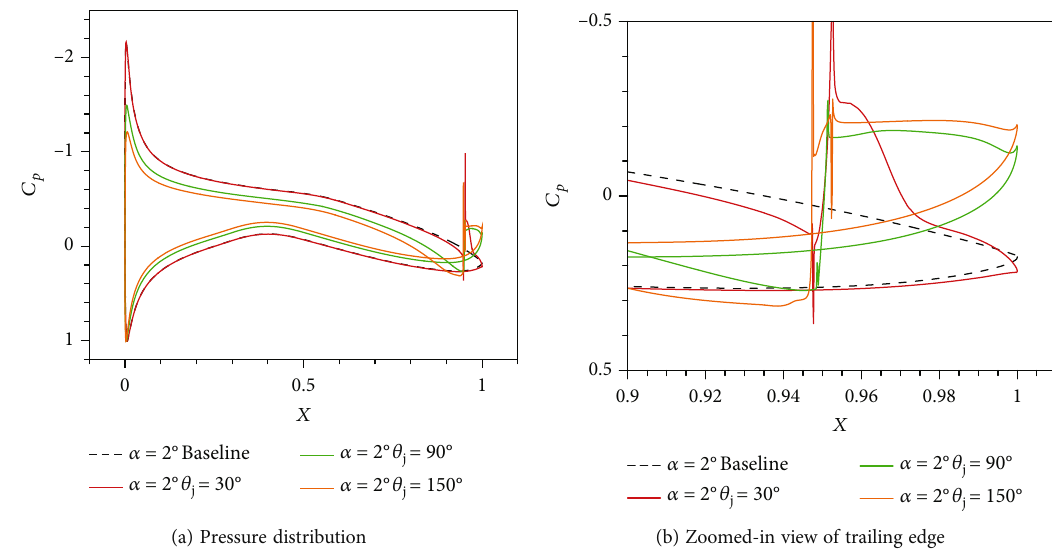
= 0 : 2 , α = 4 ° , and C = 0 : 005 . ∞ μ